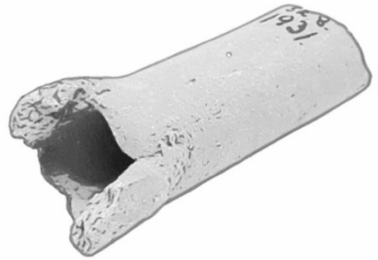
Figure 31. Piston whistle fragment, Las Palmas, Teotihuacan (EmS, Inv. 32.08.1931), length: 4.6 cm. The intact sonic artefact could be played and tested. It was observed that the instru- ment overblows easily and, in this condition, creates strong sound effects. The playing technique of overblowing is suggested by the observation that the pipe is fully muted if sounded softly and held upwards, which is when the piston is located right under the edge of the window, but that it sounds in this position when the instrument is overblown. The acoustic values generated when overblowing range between 3394 Hz (G# 7+37 ) for the lowest obtained frequency and 4441 Hz (C# 8+2 ) for the highest (Table